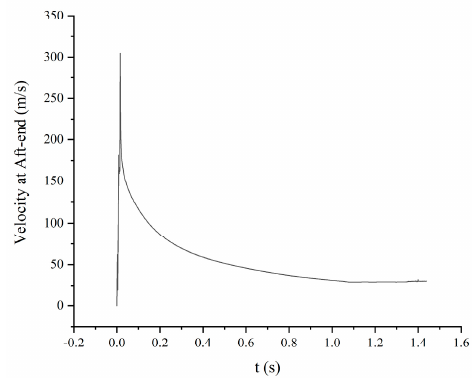
Figure 8. History of gas velocity at the aft end of the grain.